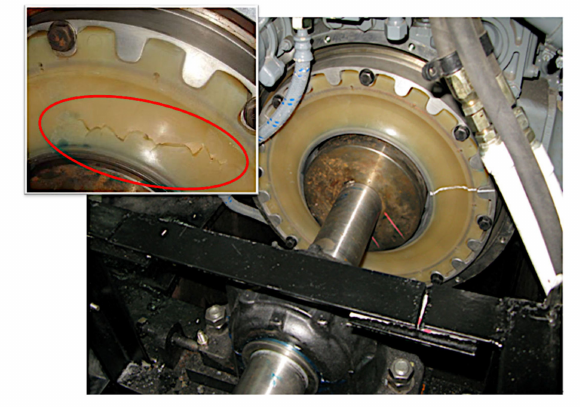
Figure 1. Damaged rubber part of flexible coupling installed between main engine and intermediate